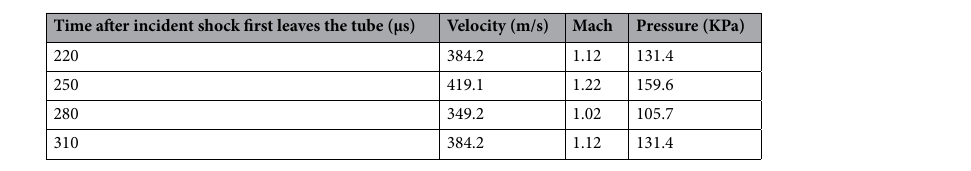
Table 3. Vortex collision shock wave